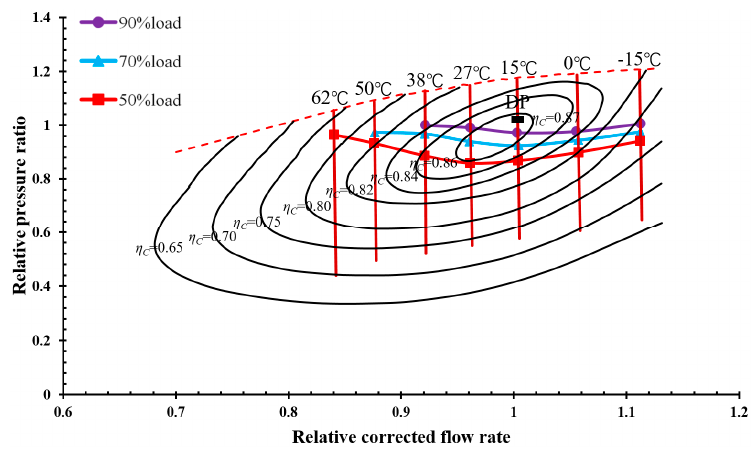
Figure 4. Equilibrium running lines on compressor characteristic line.